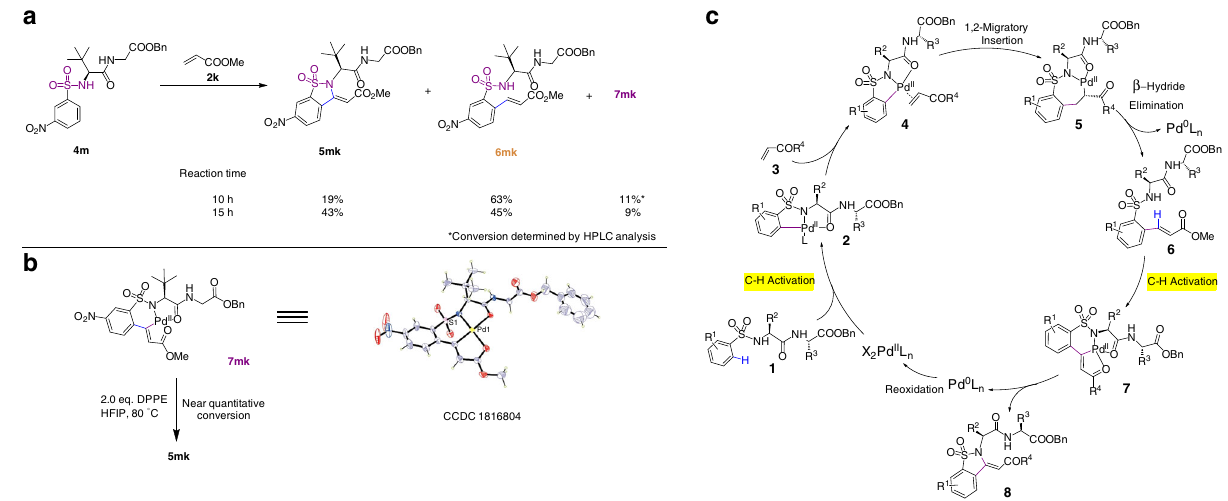
Fig. 4 Mechanistic investigation of the benzosultam cyclization reaction. a Monitoring of the reaction progress at various time points by LC – MS. b X-ray crystallographic analysis of the Pd(II) – peptide complex 7mk and its conversion to product 5mk in the presence of DPPE. ORTEP representation of the crystal structure of 7mk . Gray = carbon, blue = nitrogen, purple = sulfur, yellow = Pd. Condition: 20 mol% Pd(OAc) 2 , 2.0 eq. AgTFA, 2.0 eq. Cu(OAc) 2 , 4.0 eq. AgOAc, HFIP, 80 °C. c Proposed catalytic cycle for ole fi nation/oxidative cyclization